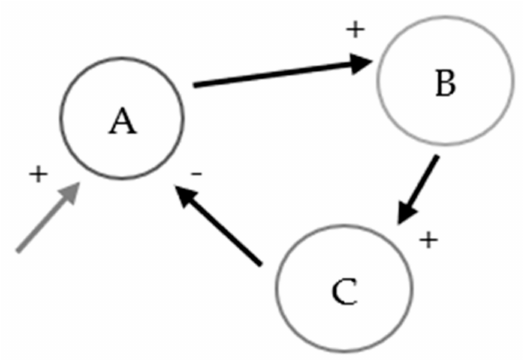
Figure 2. In this negative feedback loop physical beings A, B, and C affect each other circularly in this order with quantitatively variable effects. All other effects are ignored in this figure except one variable effect from the environment to A which can disturb the balance of the effects in the loop. The plus sign means excitatory and minus inhibitory effect. The external disturbance strengthens A’s effect, which strengthens B’s effect and, further, C’s effect; but C’s now stronger inhibitory effect weakens A’s effect, returning it to the original